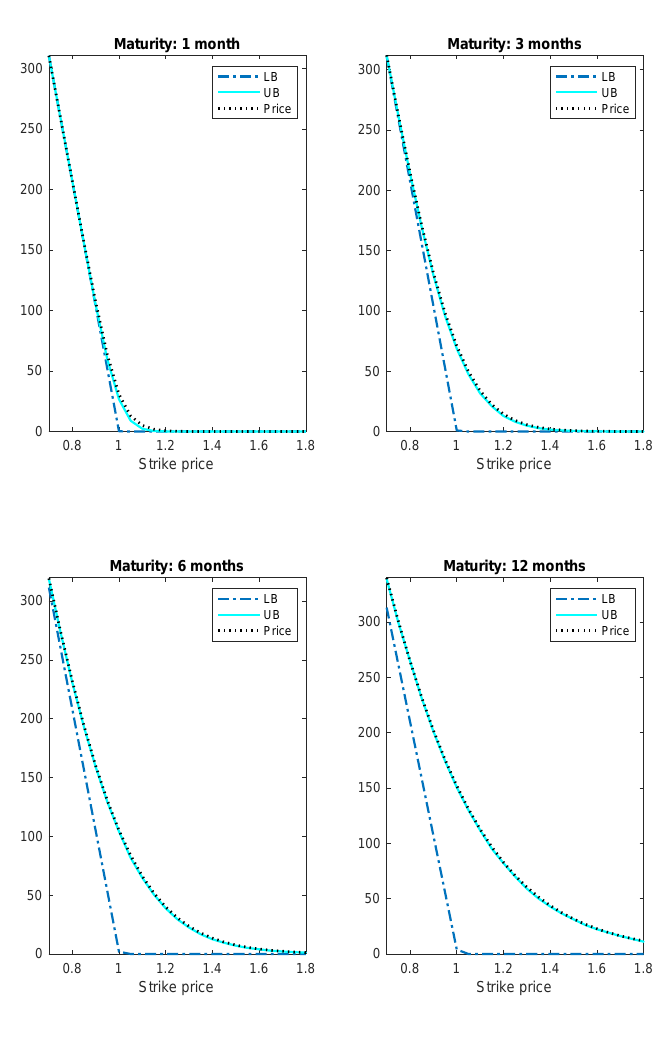
Figure 1. The lower and upper bounds and the option prices according to the strike prices. Maturities: 1, 3, 6 and 12